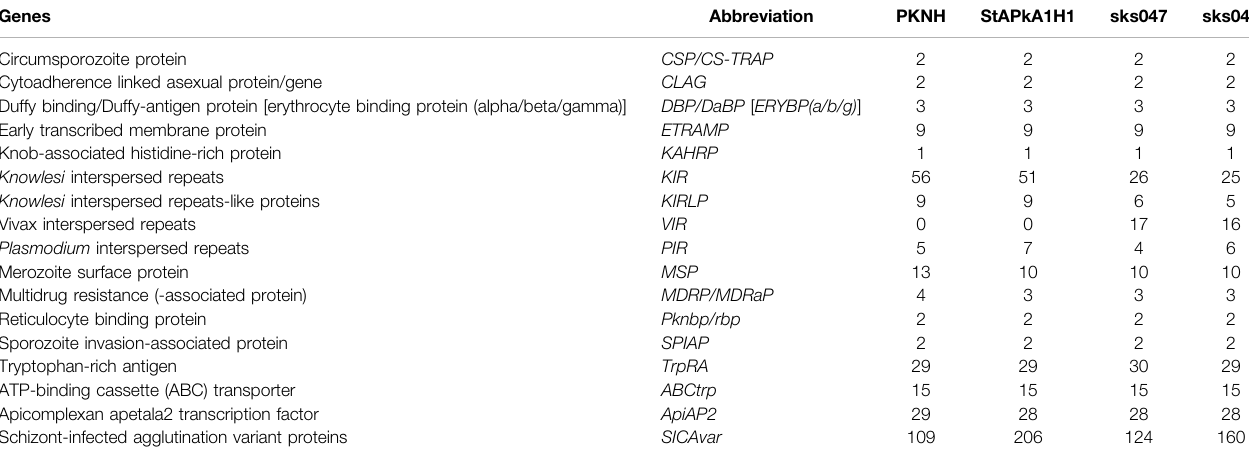
TABLE 3 | Number of annotated protein copies of the multigene families identi fi ed. Genes